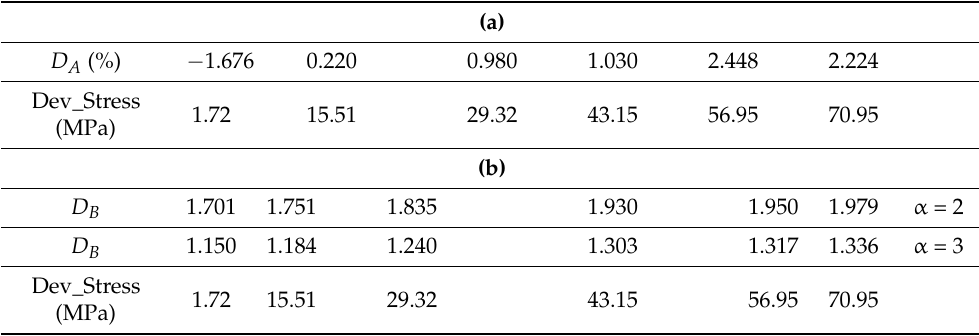
Table 2. (a) Percent apparent dispersion. (b) Percent Biot dispersion with tortuosity parameter, α , taken to be 2 or